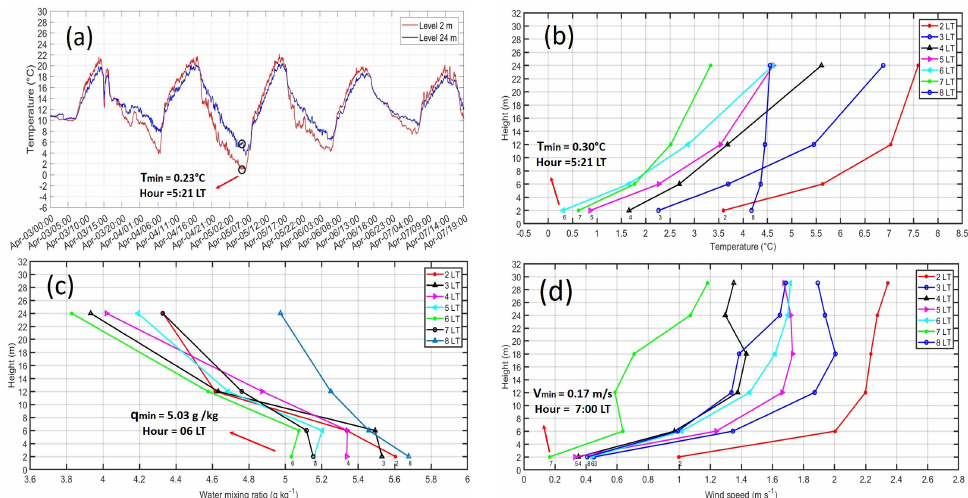
Figure 12. ( a ) Time series of air temperature ( ◦ C) at 2 m and 29 m high above the HYO between 3 April and 7 April 2019. ( b ) Mean hourly vertical profiles of air temperature ( ◦ C) during night and early morning hours of 05 April 2019. ( c ) Mean hourly vertical profiles of water mixing ratio (g kg − 1 ) during night and early morning hours of 5 April 2019. ( d ) Mean hourly vertical profiles of wind speed (m s − 1 ) during night and early morning hours of 5 April